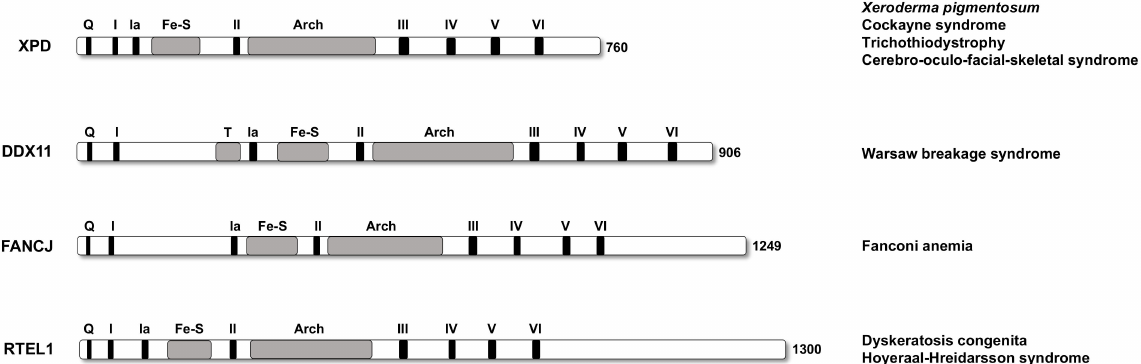
Figure 1. Human super-family 2 DNA helicases containing a Fe-S cluster. A schematic representation of the DNA helicase polypeptide chain is reported. Color code is as follows: black , conserved helicase motifs (Q motif, Q , and helicase boxes from I to VI); grey , Timeless-binding motif ( T ) [9], Fe-S cluster ( Fe-S ) and Arch domain ( Arch ) domain. The related rare hereditary diseases are indicated for each DNA